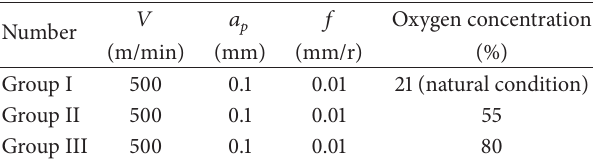
Table 1: Cutting